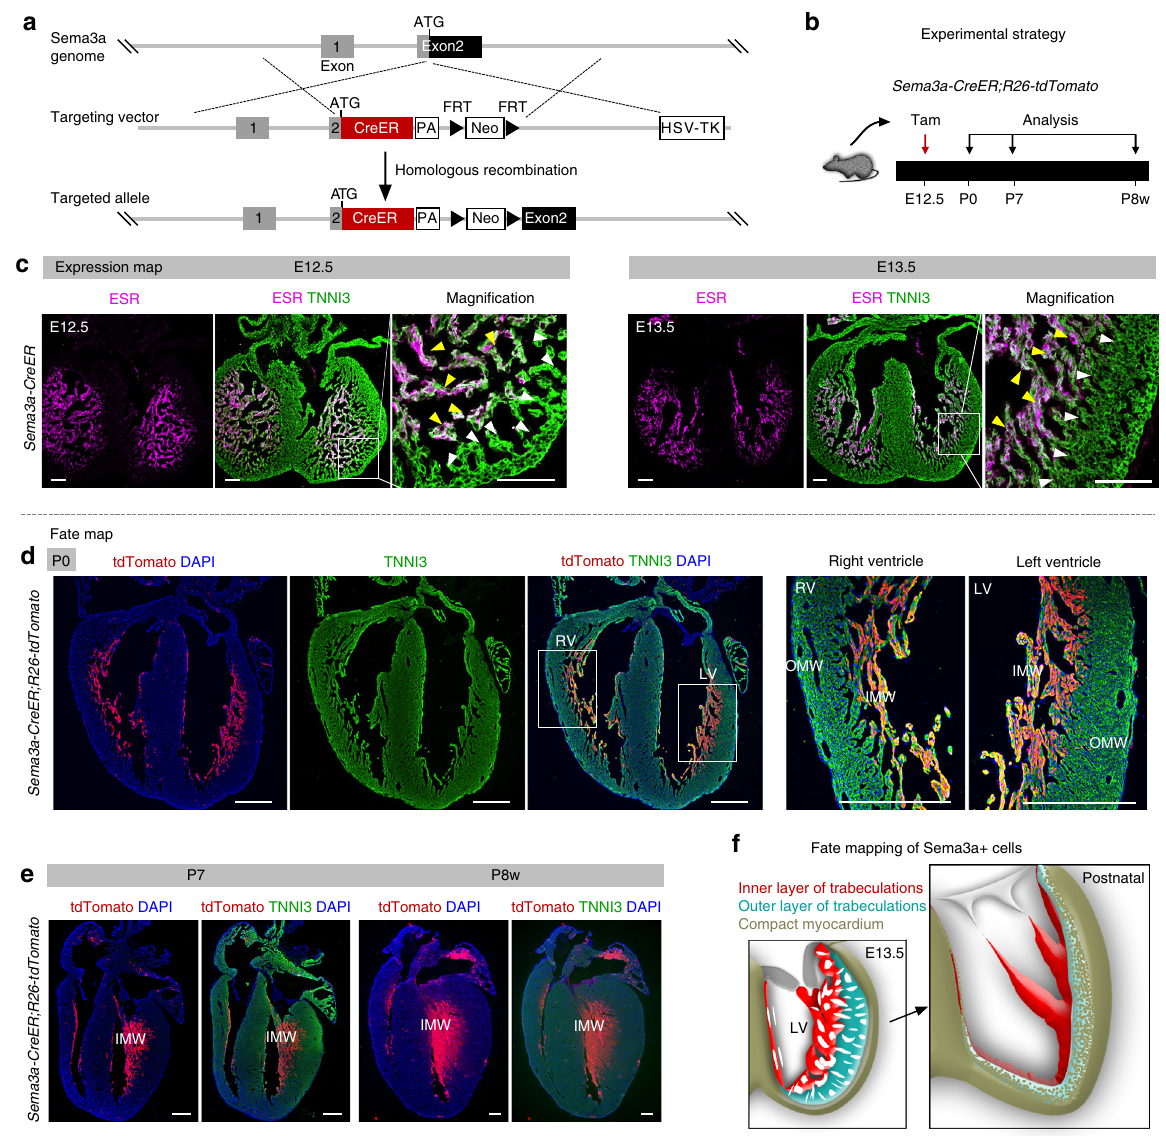
Fig. 7 Sema3a + cells contribute to the innermost layer of ventricle wall in postnatal heart. a Schematic showing strategy for generation of Sema3a-CreER knock-in allele by homologous recombination. b Experimental strategy for tamoxifen administration and tissue analysis. c Immunostaining for ESR and TNNI3 on E12.5 and E13.5 Sema3a-CreER hearts. Most Sema3a + (ESR + ) cells were detected in inner trabecular layer ( yellow arrowheads ) but not in outer trabecular layer ( white arrowheads ). d , e Immunostaining for tdTomato and TNNI3 on heart section from P0, P7, and P8w (8 weeks) Sema3a-CreER;R26- tdTomato hearts. Sema3a-derived cells are restricted in the innermost layer of ventricle wall (IMW) in postnatal heart. f Cartoon image showing cell fate of Sema3a + cells in postnatal heart. Scale bars, 100 µ m in c ; 500 µ m in d , e ; Each image is representative of four individual